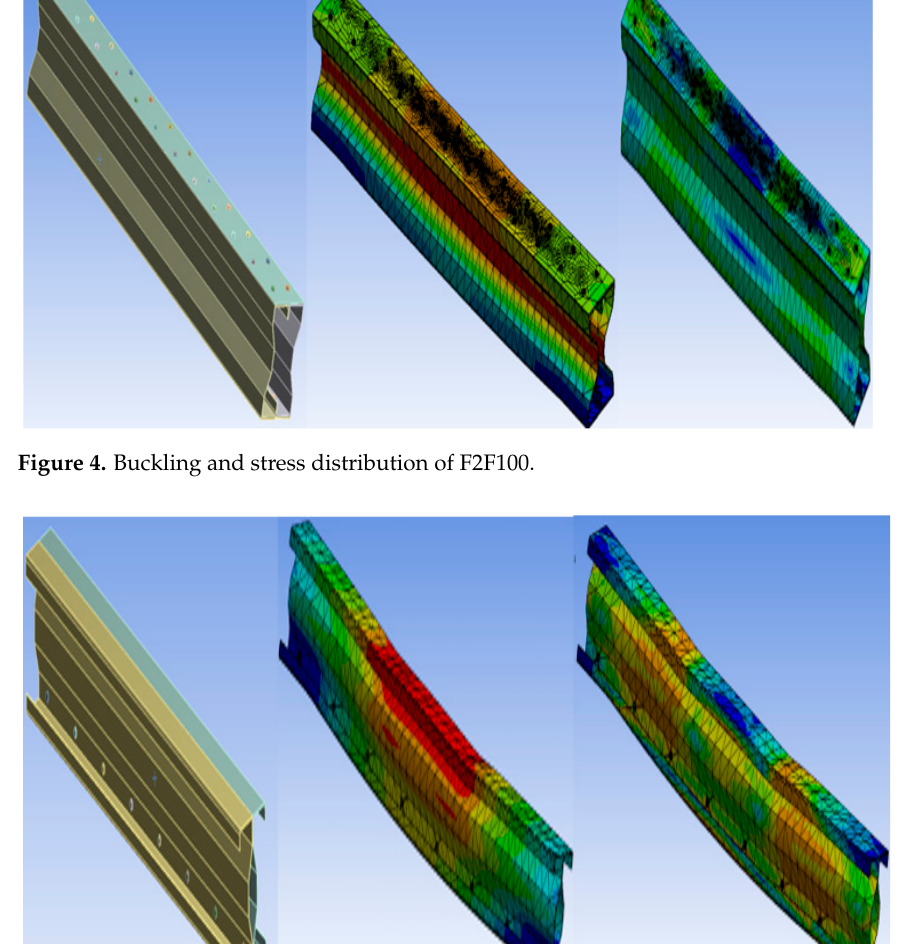
Figure 3. Buckling and stress distribution of B2B100.